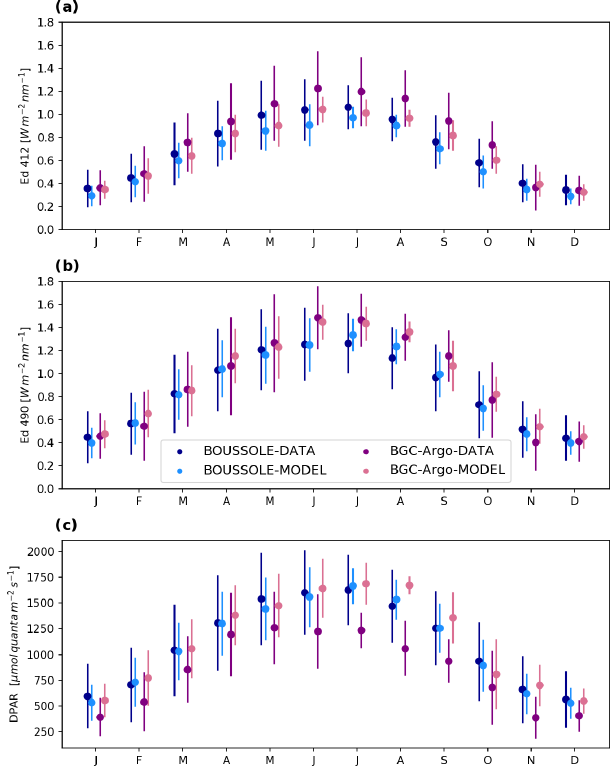
Figure 12. Scatter plots of the climatological monthly mean values and standard deviations of the downward ir- radiance E d (λ = 4124900 − ) (Wm − 2 nm − 1 ) and DPAR (µmolquantam − 2 s − 1 ). The blue dots represent the mean values of the measurements at the BOUSSOLE site and the corresponding model outputs, whereas the lilac points display the BGC-Argo values and model means, resulting from the match-up of all available profiles within the 1 ◦ window ( ± 0 . 5 ◦ N/S and W/E from the location of the BOUSSOLE buoy). Note that the points corresponding to each month are horizontally shifted to increase the readability.